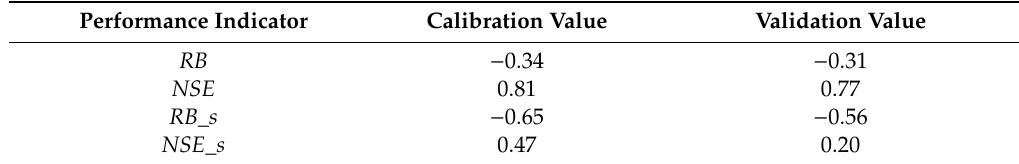
Table 5. Performance indicators of the original IHACRES model.